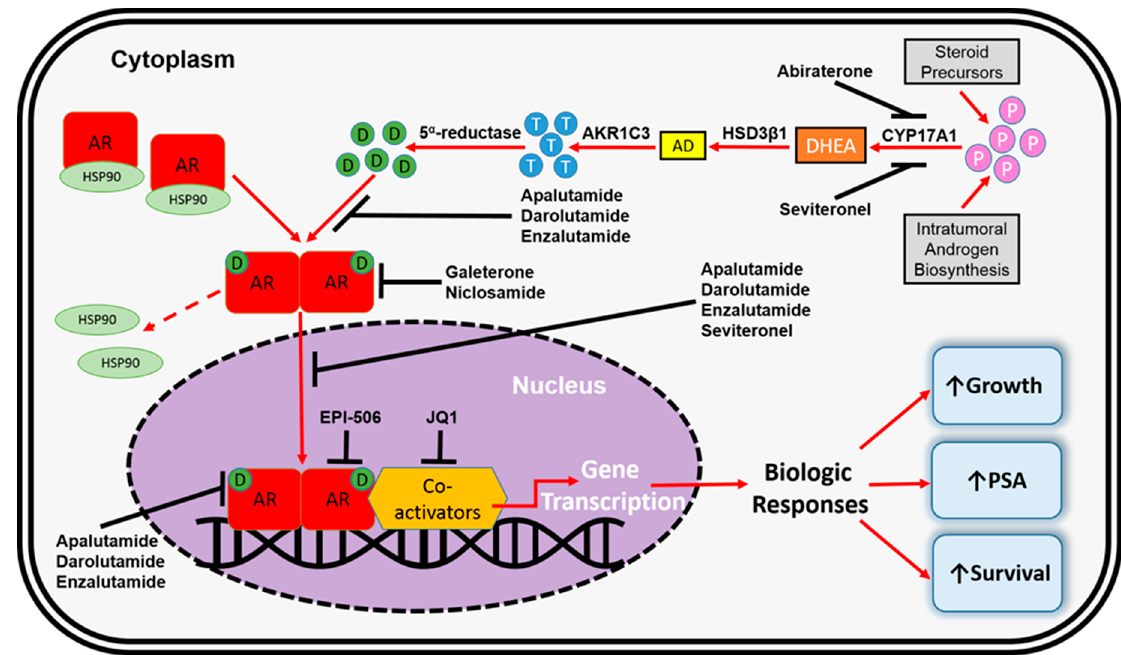
Figure 2. AR signaling axis, and mechanisms of AR targeted inhibition. CYP17A1 is the enzyme responsible for the conversion of androgen precursors (i.e., pregnenolone and progesterone; represented by the light purple circles) to DHEA, while HSD3 β 1 converts DHEA to AD, AKR1C3 converts AD to testosterone (represented by the blue circles) and finally 5 α -reductase converts testosterone to dihydrotestosterone (DHT; represented by the green circles). DHT-mediated activation of the AR causes a conformational change where the AR dimerizes, which then triggers AR translocation into the nucleus. Abiraterone selectively and irreversibly inhibits intratumoral androgen biosynthesis by potently blocking CYP17A1. As a result, less ligand is available for AR activation and AR axis signaling. Seviteronel (VT-464) is also an inhibitor of CYP17A1. Seviteronel has also been shown in preclinical models to have direct inhibitor effects on the AR. Enzalutamide is a potent second-generation antiandrogen that antagonizes the AR, prevents AR translocation into the nucleus, and inhibits AR-mediated transcription. Apalutamide (ARN-509) and darolutamide (ODM-201) are also potent, competitive AR inhibitors with similar mechanisms of action to enzalutamide. EPI-506 reduces AR transcriptional activity by inhibiting protein-protein interactions between the AR and its transcriptional co-regulators. JQ1 is a bromodomain inhibitor that limits AR transcriptional ability by targeting its coactivators. Abbreviations: AD, androstenedione; AKR1C3, aldo-keto reductase family 1 member C3; AR, androgen receptor; CYP17A1, cytochrome P450 c17; DHEA, dehydroepiandrosterone; D, dihydrotestosterone; HSP, heat shock protein; HSD3 β 1, human 3-beta-hydroxysteroid dehydroxynase/delta5-4 isomerase type 1; P, androgen precursors; PSA, prostate-specific antigen; T, testosterone.